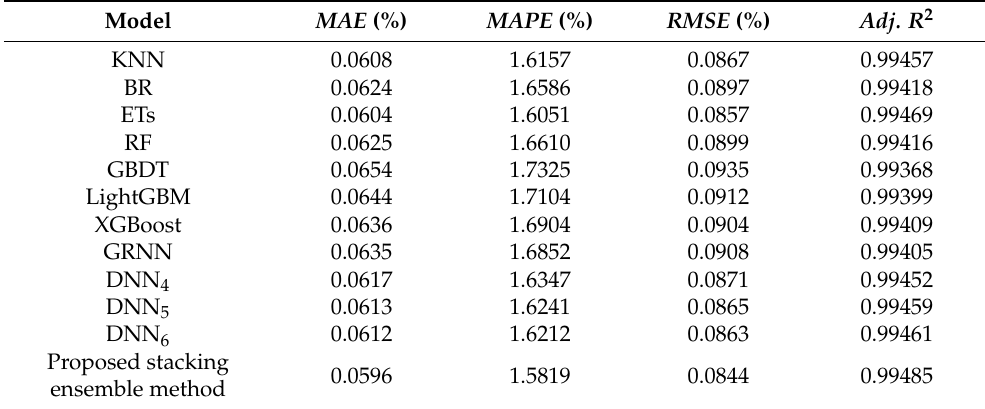
Table 5. Performance comparison of the proposed stacking ensemble method and other